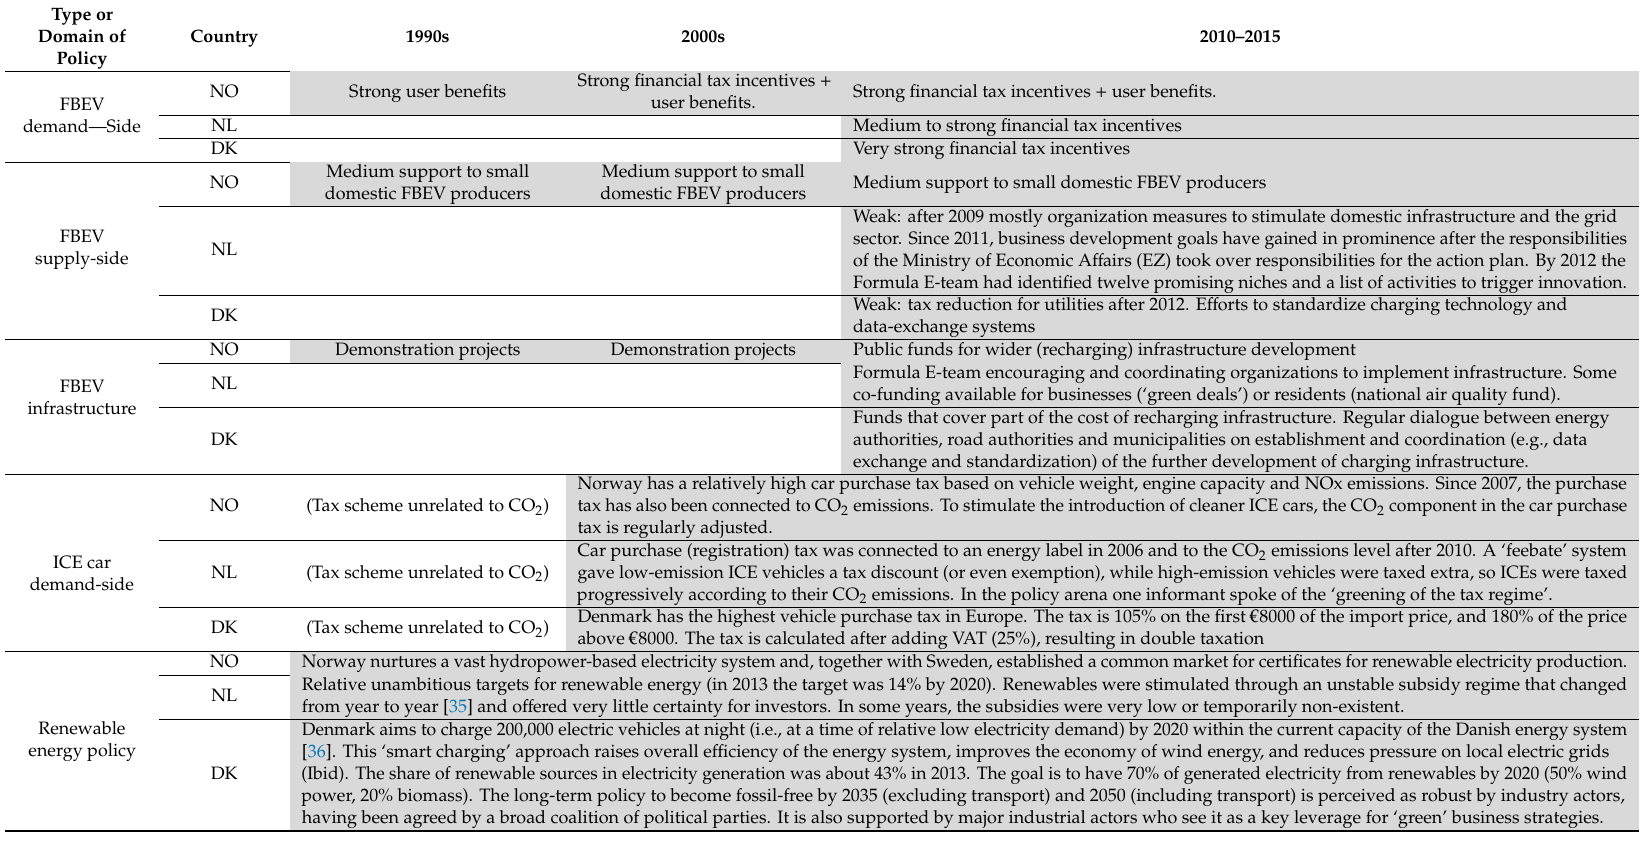
Table 2. Policies shaping electric mobility in Norway, the Netherlands and Denmark,